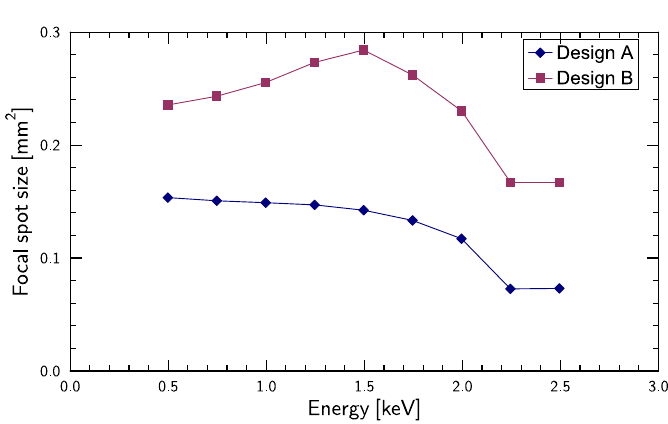
Fig. 3. Dependence of the focal spot size S s on photon energy.